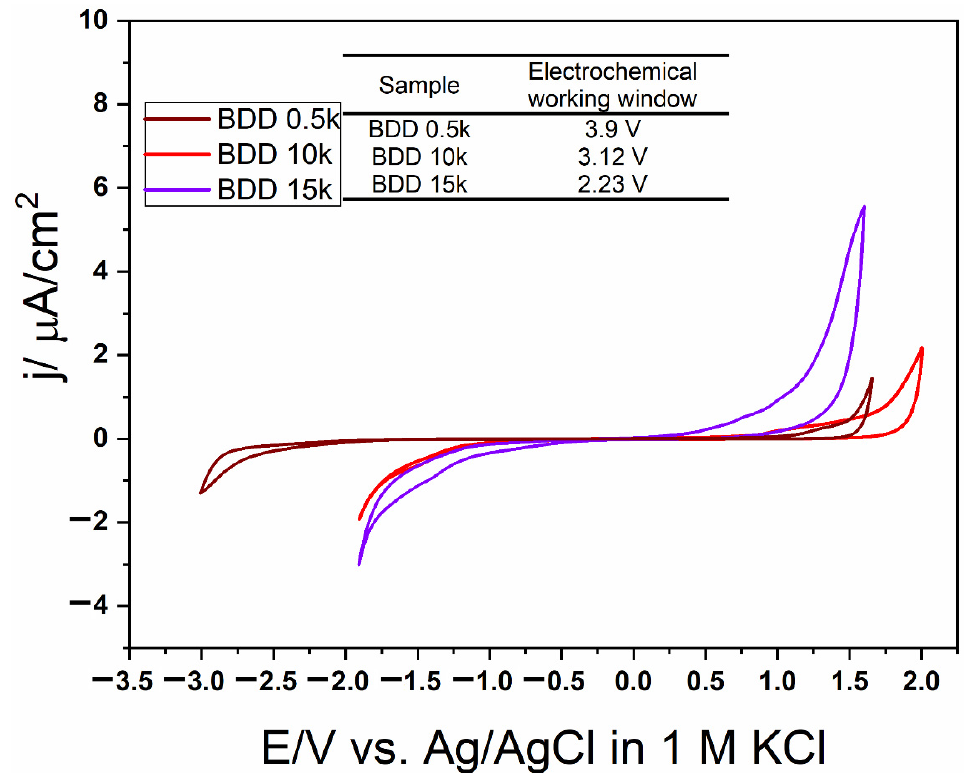
Figure 4. Cyclic voltammetry plots for BDD films with different boron doping recorded in 1 M KCl with 100 mV/s scan rate.